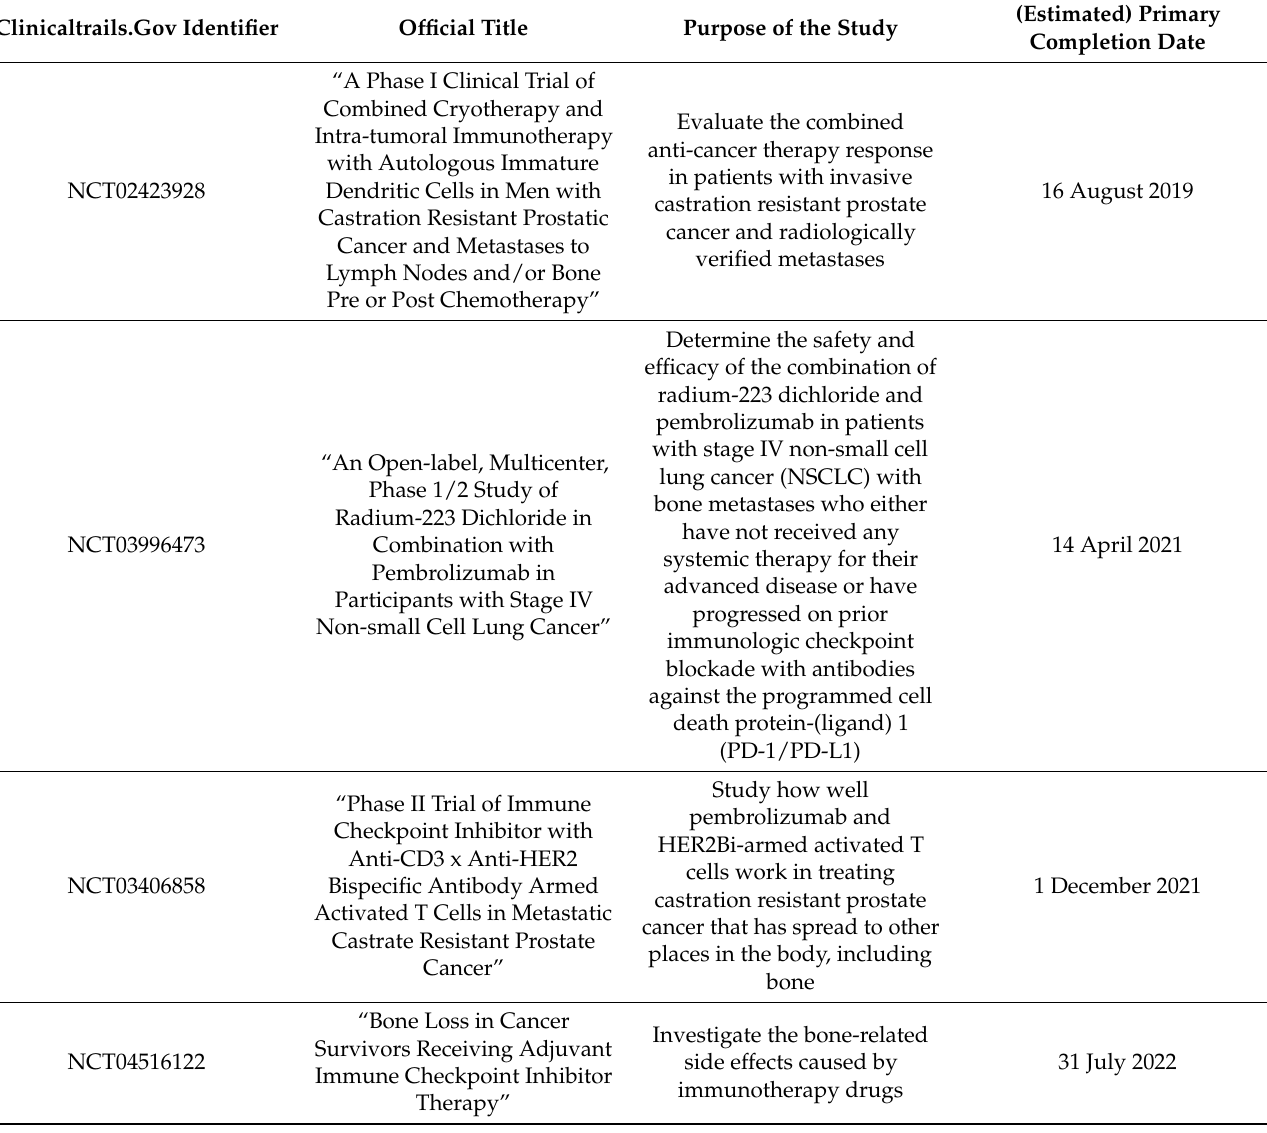
Table 3. Examples of clinical trials involving immune